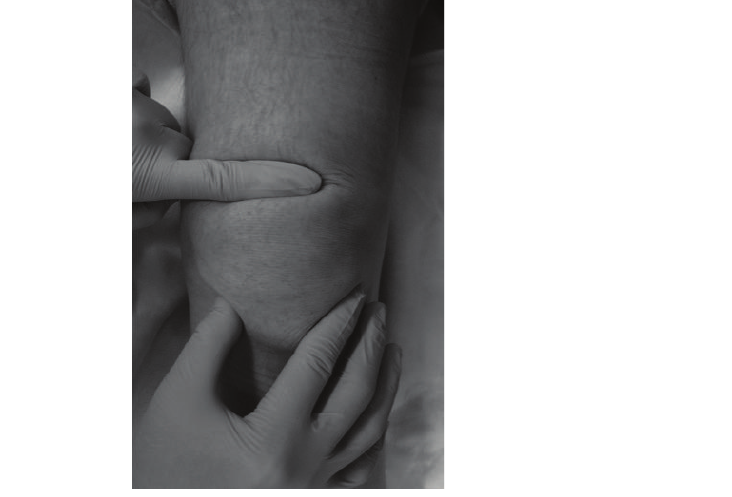
Figure 1: Macroscopic photograph of clinical findings. A tendon defect was (1.5cm in size) proximal to the patella that was palpable.